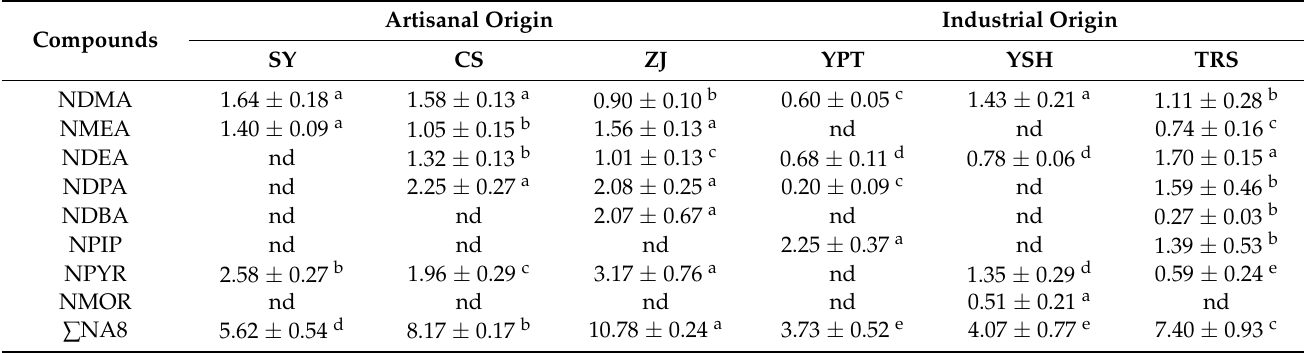
Table 2. Content of nitrosamines ( µ g/kg) in Larou of artisanal and industrial origin. Compounds